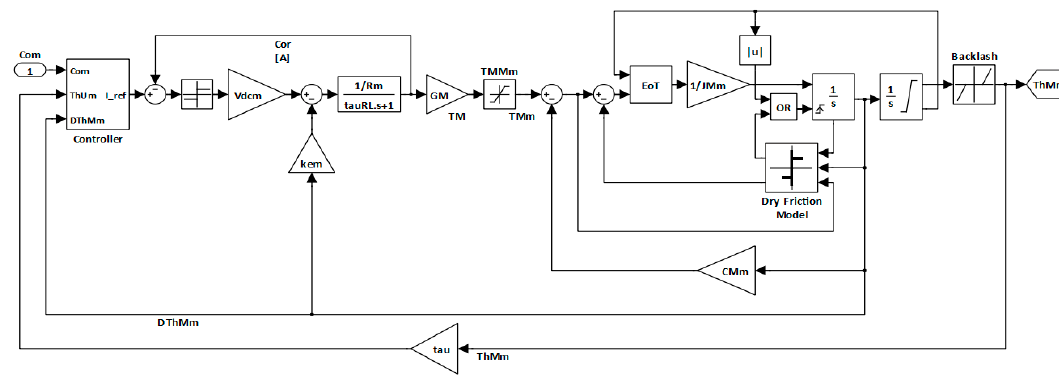
Figure 3. Detailed block diagram the Monitor Model (MM) employed in this work.